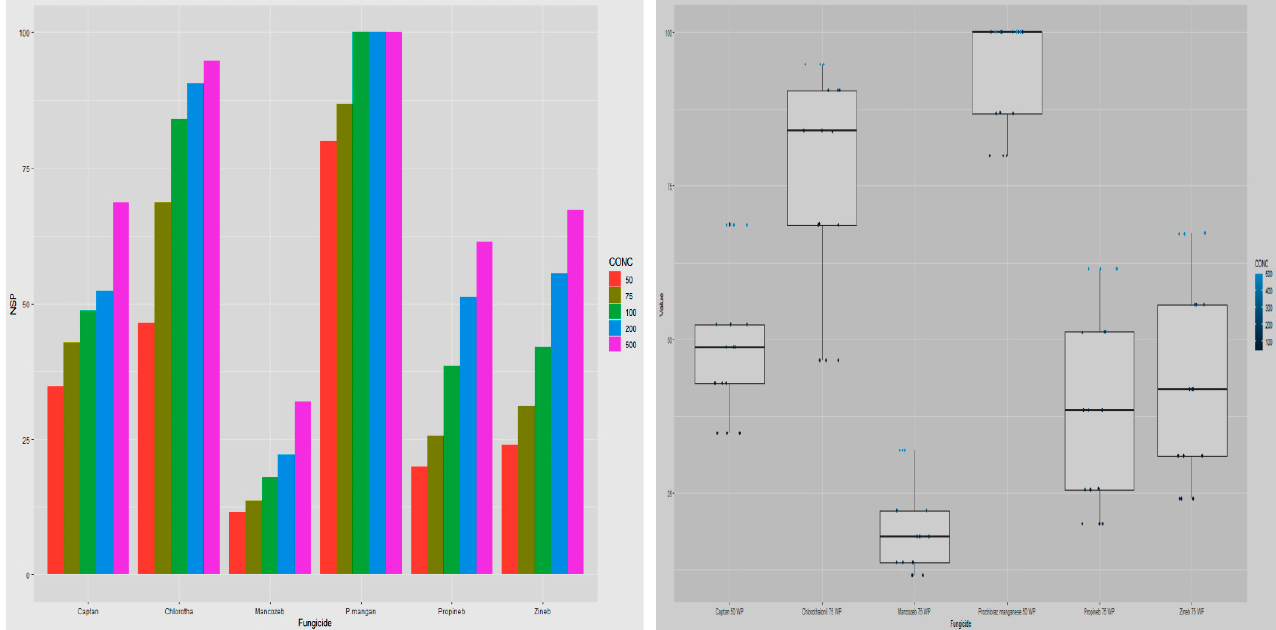
Figure 2. Comparative bar chart ( left ) and Boxplots ( right ) describe the effect of non-systemic fungitoxicants under in vitro conditions against T. harzianum mycelium .